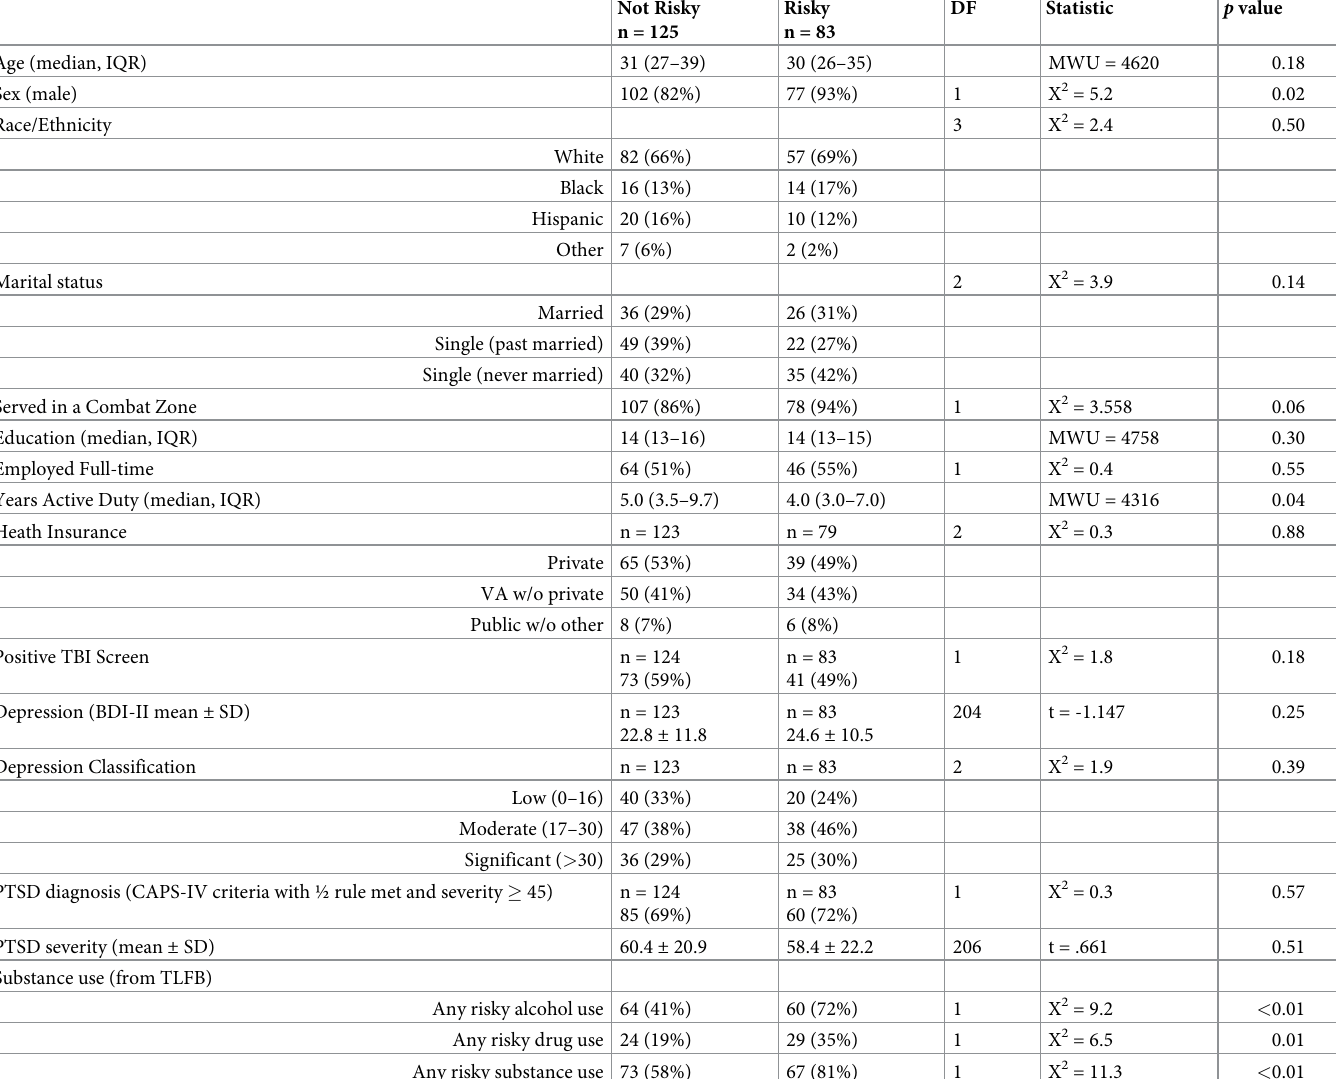
Table 1. Characteristics of Veterans with risky and non-risky substance use documented in C&P